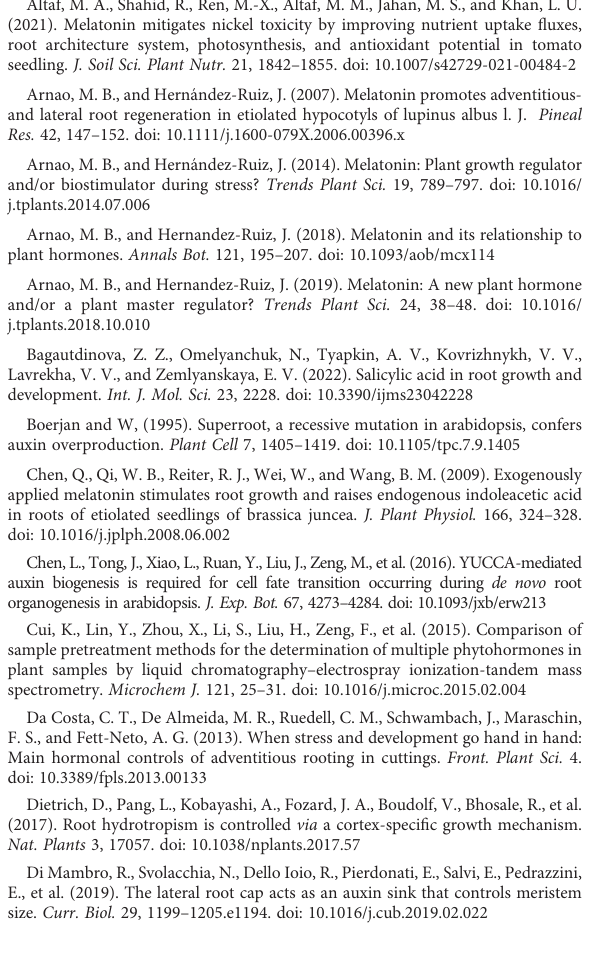
SUPPLEMENTARY FIGURE 2 GO enrichment analysis of DEGs.